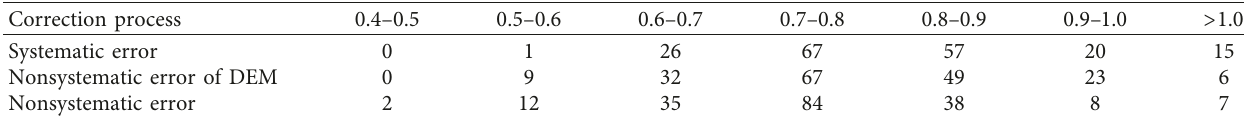
Table 4: Distribution of ratios of RMSE of corrected 24 h forecast of geopotential height on 500hPa to the forecast of GRAPES model. Correction process